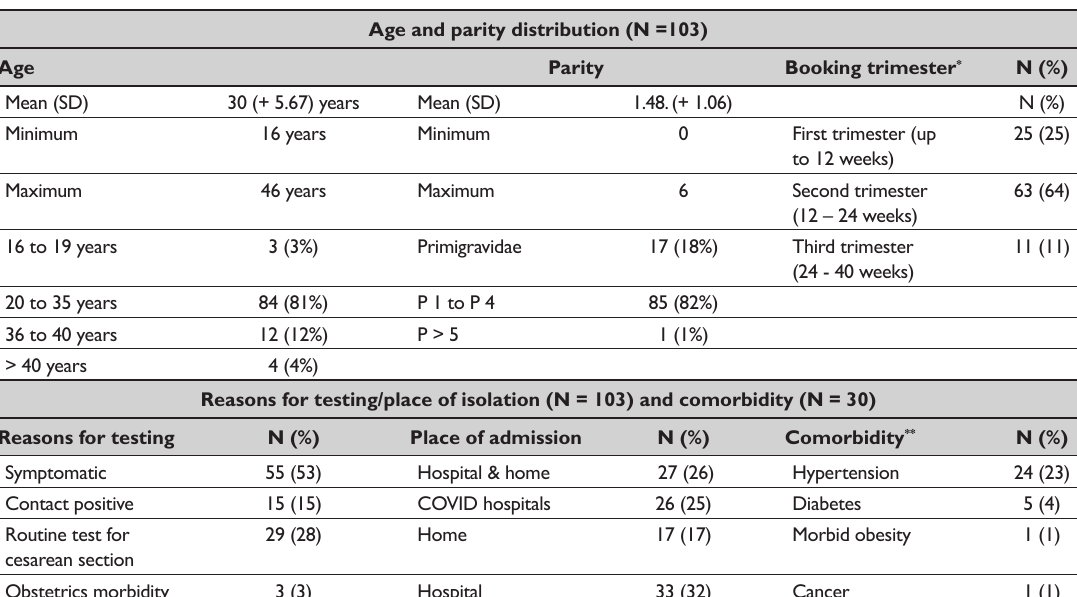
Table 1: Demographic characteristics and comorbidities of COVID-19 positive pregnant and postpartum women, Ekurhuleni Health District, Gauteng province, South